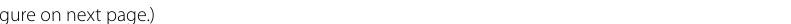
figure on next Fig. 3 EXTEM lysis indices (LIs) at 45 min ( a ) and 60 min ( b ) in blood samples of healthy volunteers ( n blue dots) and patients with septic shock ( n 30; red dots). Data of patients with septic shock and surgical patients are presented for the timepoints = onset (sepsis onset or immediately after the surgical procedure) as well as 3 h, 6 h, 12 h, 24 h, 48 h and 7 d later, whereas blood samples from healthy volunteers were collected only once. A P value < 0.05 was considered statistically